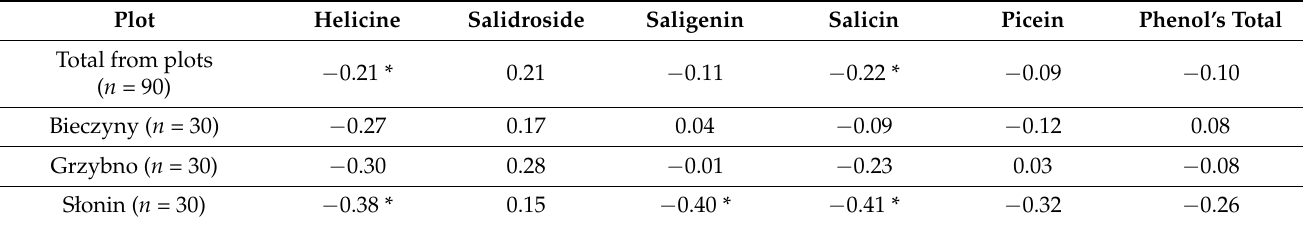
Table 6. The Spearman’s rank correlation coefficients between the extent of foraging in the evaluated plots vs. specific salicylic compound content in willow. * Significant at p < 0.05.